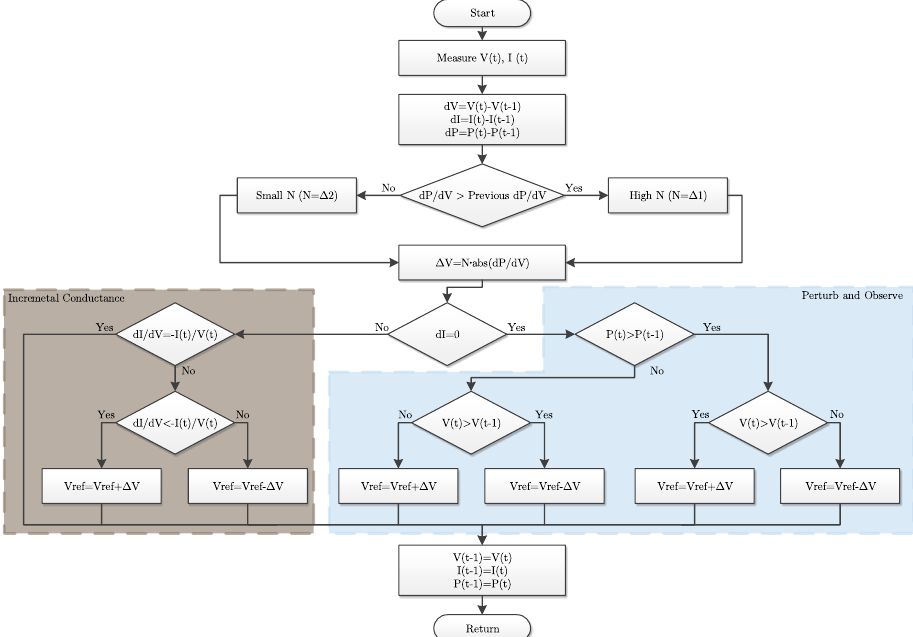
Figure 2. Hybrid MPPT applied to push–pull